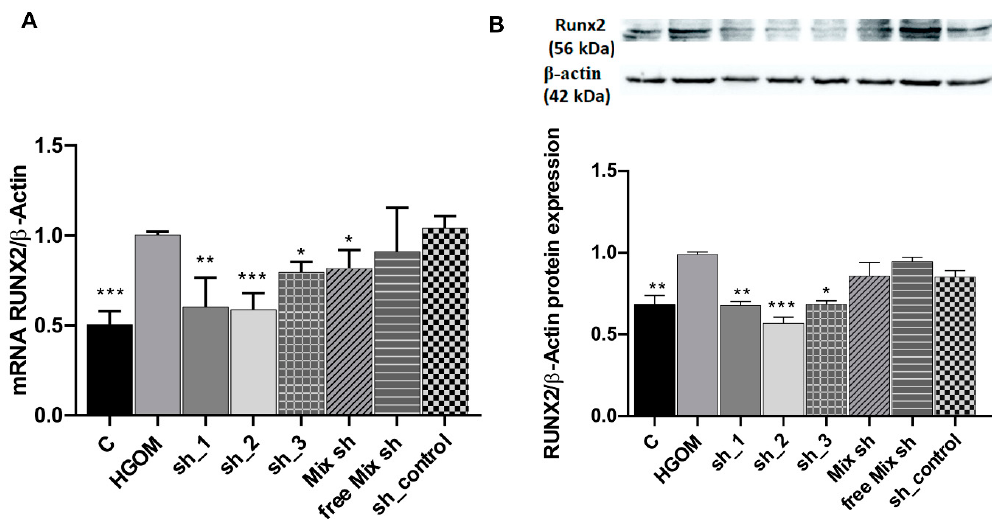
Figure 3. Down-regulation of Runx2 mRNA (A) and protein (B) expression in HGOM-treated VIC and transfected with C60-PEI/shRNA-Runx2 plasmids polyplexes containing different shRNA sequences specific for Runx2 (sh_1, sh_2 and sh_3) and then investigated at 48 hours after transfection. Results, normalized to β -actin, were expressed as mean ± S.D. of three experiments made in duplicate (n=6) and represent fold change relative to HGOM condition (considered as 1). *p < 0.05, **p<0.01, and represent fold change relative to HGOM condition (considered as 1). * p < 0.05, ** p < 0.01, ***p<0.001 compared with HGOM. *** p < 0.001 compared with